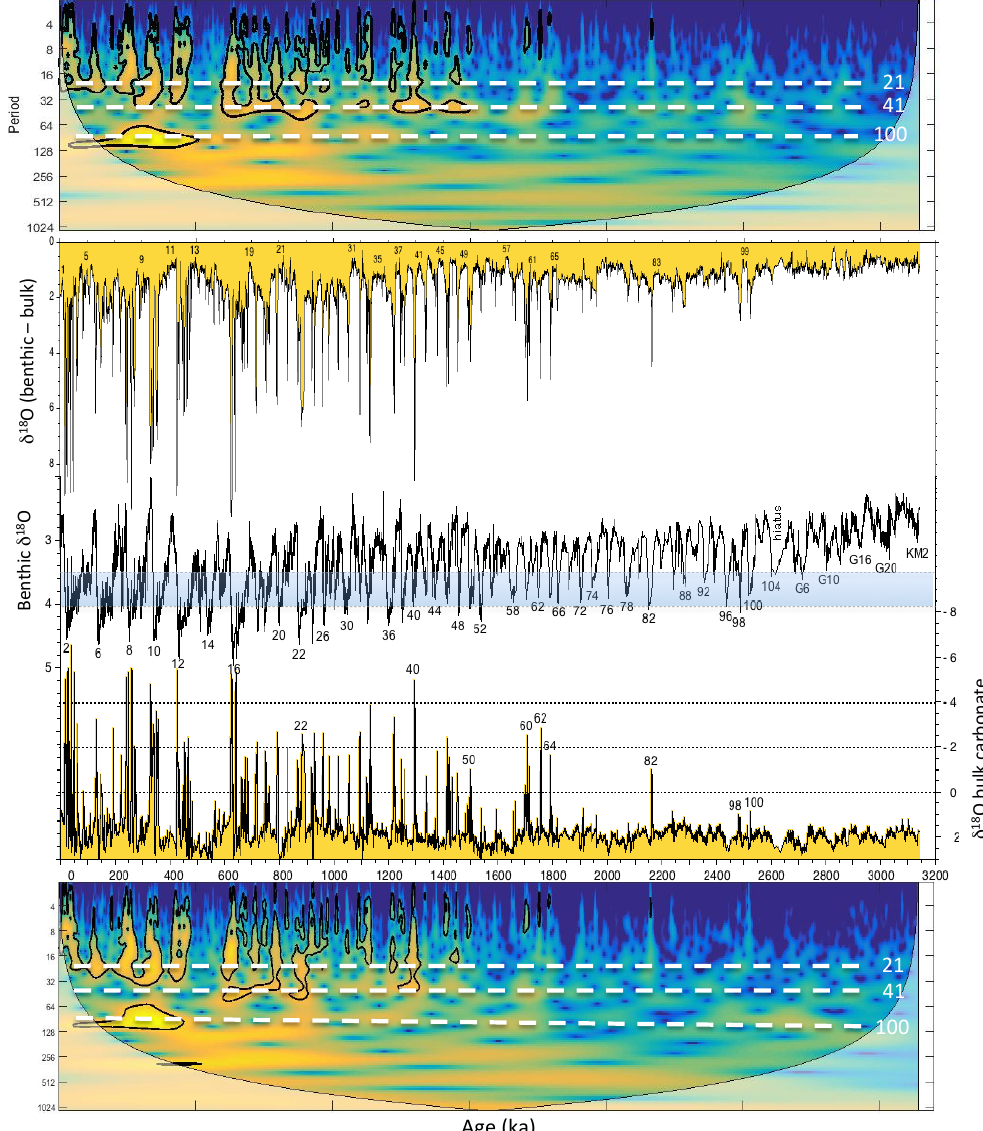
Figure 5. The δ 18 O of bulk carbonate (lower) and the difference between benthic and bulk δ 18 O (upper) shown relative to the benthic δ 18 O record (middle) of Site U1308. Prominent marine isotope stages are labeled. The shaded region between 3.5 and 4.0‰ represents the window for millennial variability as defined by McManus et al. (1999). Top and bottom panels are continuous wavelet transform of the density and bulk δ 18 O records of Site U1308, respectively. Black contours on the wavelet plots indicates the 5% significance level against red noise. The horizontal dashed white lines represent the orbital periods of precession ( ∼ 21kyr), obliquity ( ∼ 41kyr), and eccentricity ( ∼